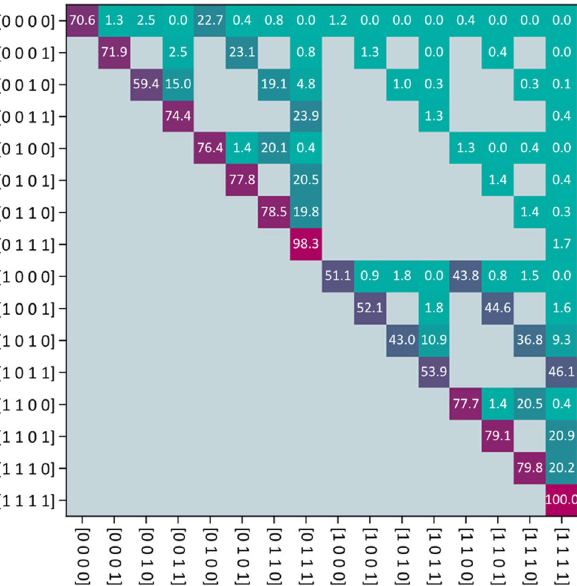
Figure 3. Transition matrix. All gray pixels in this image correspond to entries in the matrix being zero. The colored pixels take on values ∈ [0, 1] which are here overlayed in %. The exact values stem from the mean of the learned parameters in "Application to oropharyngeal HNSCC" section. The exact shape of the grey “mask” depends on how one orders the